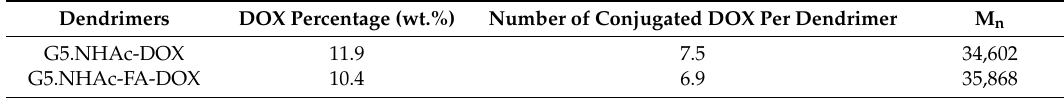
Table 1. Characteristics of dendrimer-doxorubicin (DOX) conjugates. Dendrimers DOX Percentage (wt.%) Number of Conjugated DOX Per Dendrimer